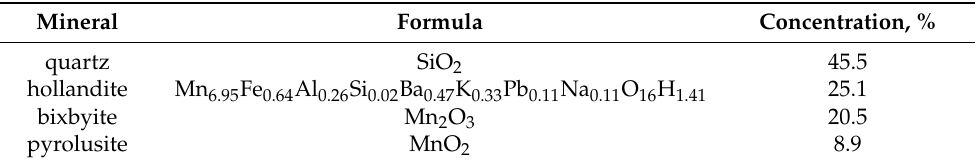
Table 7. Results of semantical XRD analysis of crystalline phases of manganese ore sample from the Zhaksy deposit.